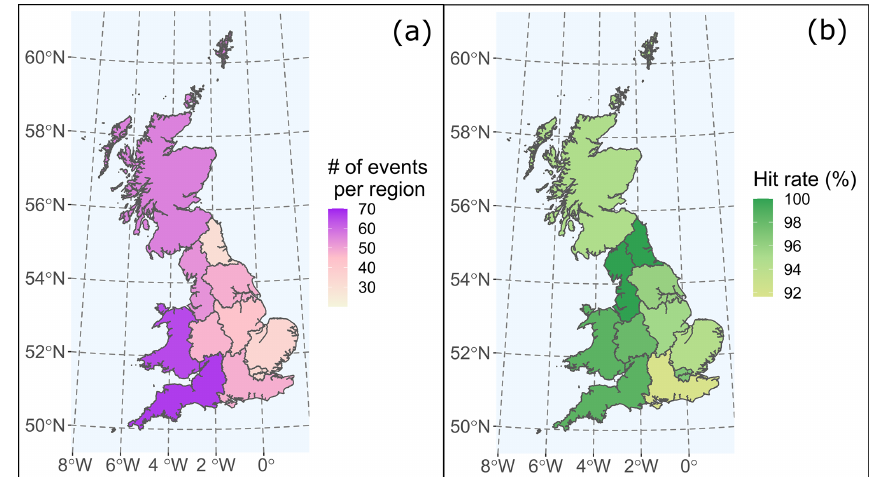
Figure 11. Map of Great Britain divided into 11 NUTS1 regions showing (a) the number of events per region from our Great Britain Significant Weather Events Catalogue 1979–2019 (Supplement 4) and, (b) for each region, the hit rate (ratio between the number of joint events and the total number of events in our significant weather events